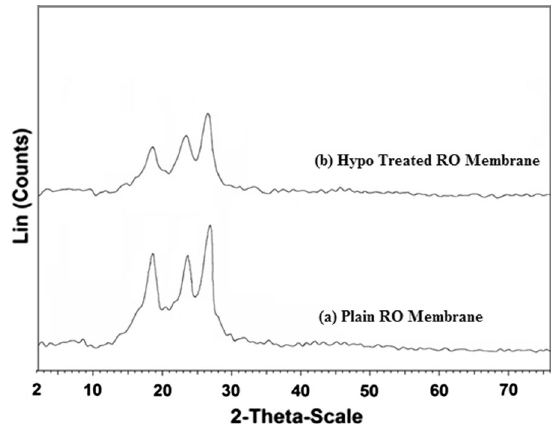
Fig. 6 X-ray diffraction spectra of a plain RO membrane and b hypo- treated RO membrane exposure time of 900 min was evaluated in terms of